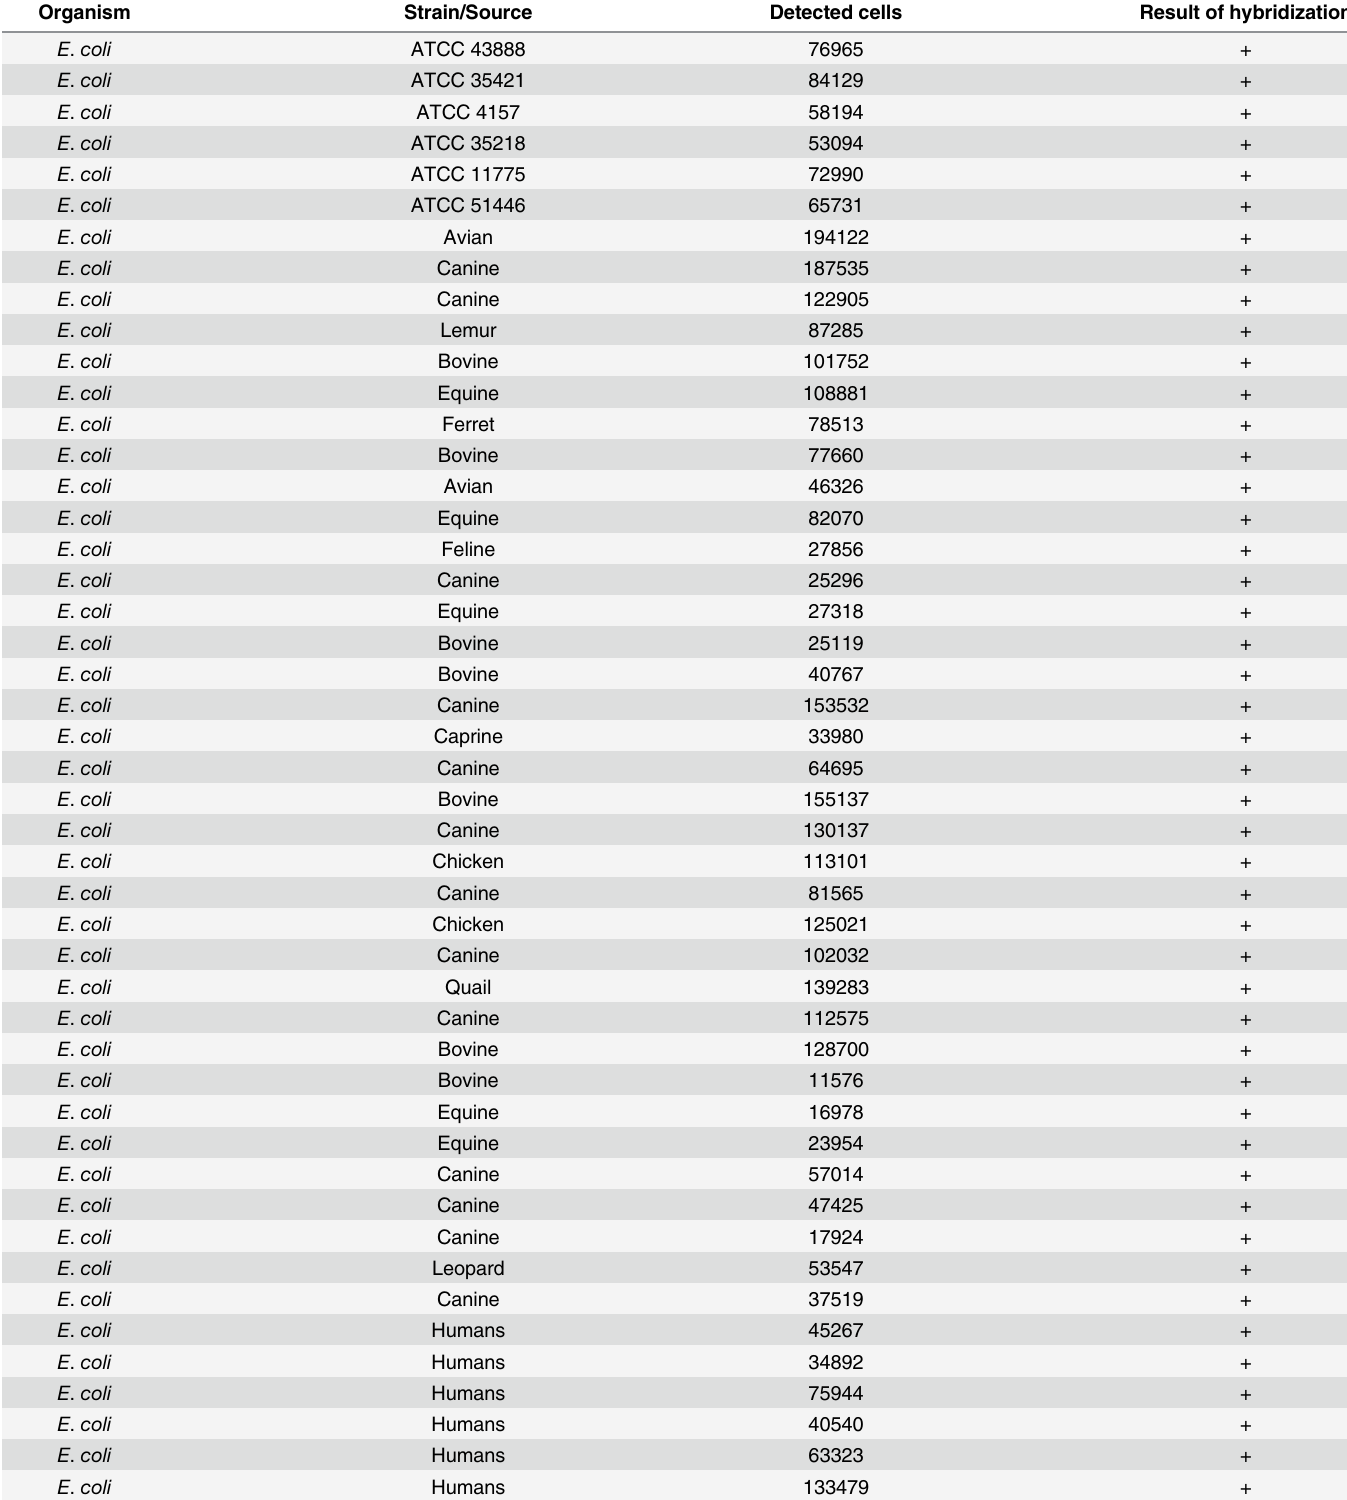
Table 1. Inclusivity panel